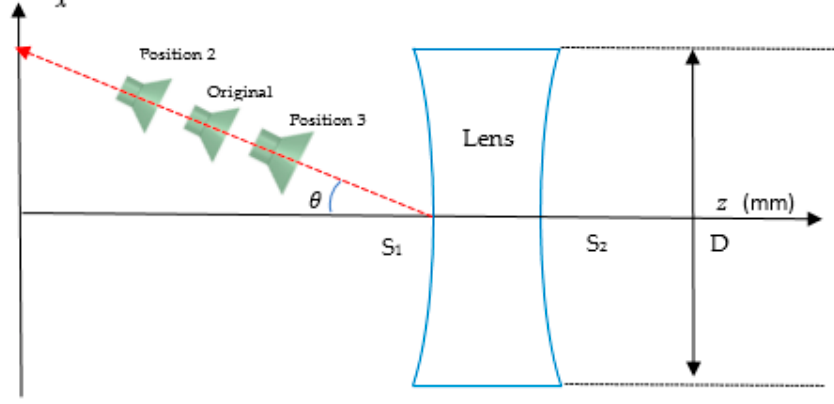
Figure 25. Feed position analysis arrangement.